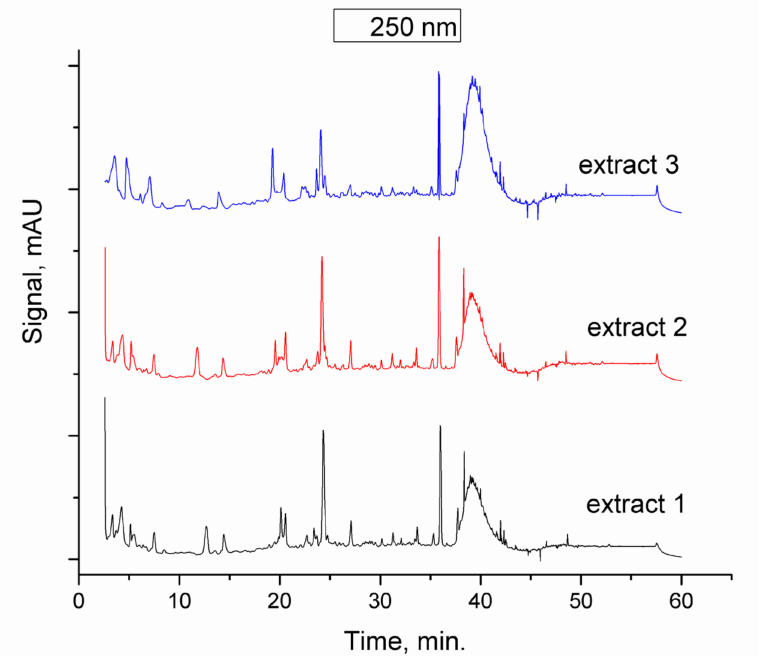
Figure 1. HPLC chromatograms of EtOH:H 2 O (70:30 v : v ) Anthriscus sylvestris extract with detection at 250